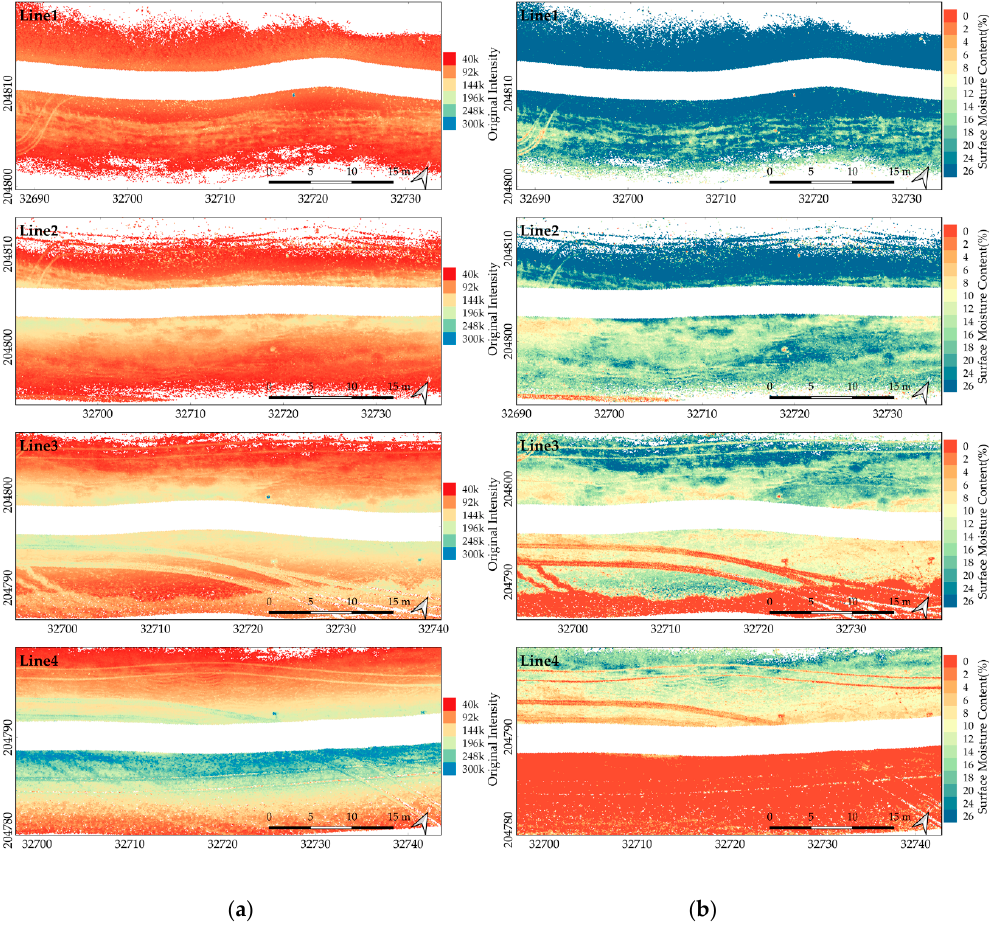
Figure 10. ( a ) Beach surface with the original intensity of four survey lines before correction and ( b ) beach surface moisture content of the same four survey lines after correction. Table 5. The difference between the real sample moisture contents and the derived moisture content based on eight sand samples collected from the target beach.